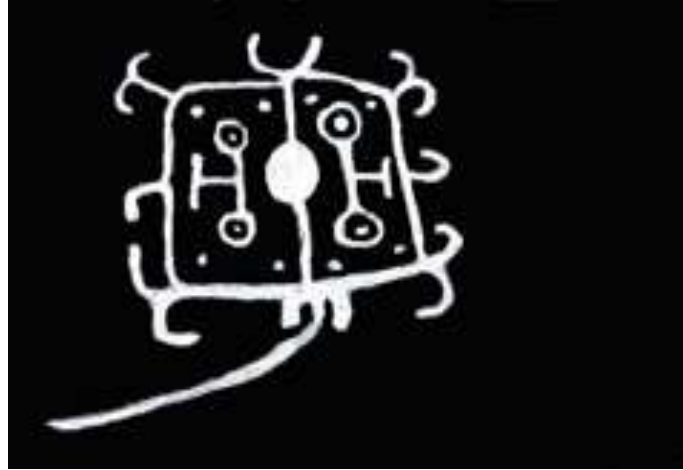
Figure 2. Hawraman, Bendoul, Havar-Sivieh, Rangavarzhilah rock, geometric marking with dimensions of 90 cm by 106